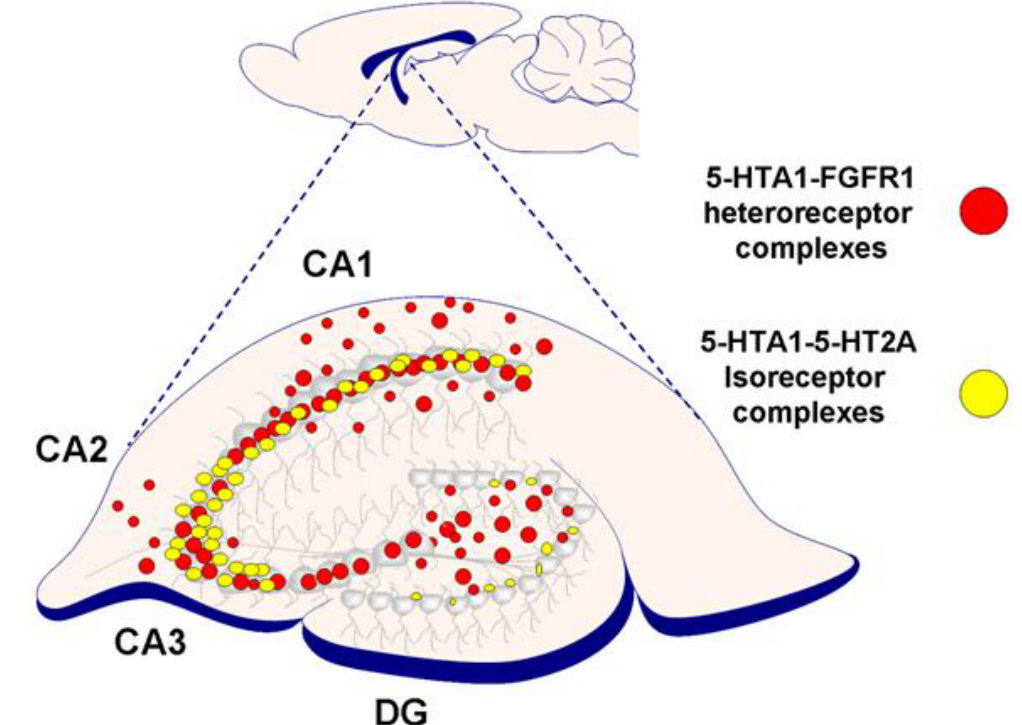
Figure 3. Illustration of the distribution pattern of 5-HT1A–FGFR1 heteroreceptor and 5-HT1A–5-HT2A isoreceptor complexes visualized with PLA in the rat dorsal hippocampus. The 5-HT1A–FGFR1 heteroreceptor complexes, in red, have a more widespread distribution, mainly located within the pyramidal cell layer of the CA1–CA4 and in the plexiform cell layer of the dentate gyrus. However, they exist in low densities in the stratum oriens and radiatum of the CA1–CA4 regions and the subgranular layer. Instead, the 5-HT1A–5-HT2A isoreceptor complexes, shown in yellow, are concentrated to the pyramidal cell layer of the CA1–CA3 regions, with some located in the subgranular layer of the dentate